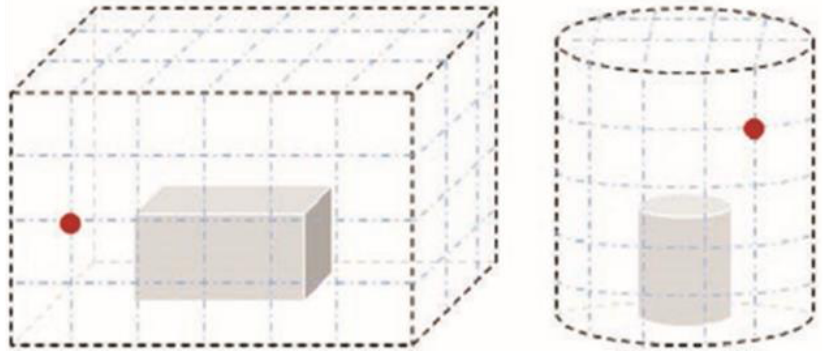
Figure 4. Measurement surfaces with measurement points indicate by grid lines .